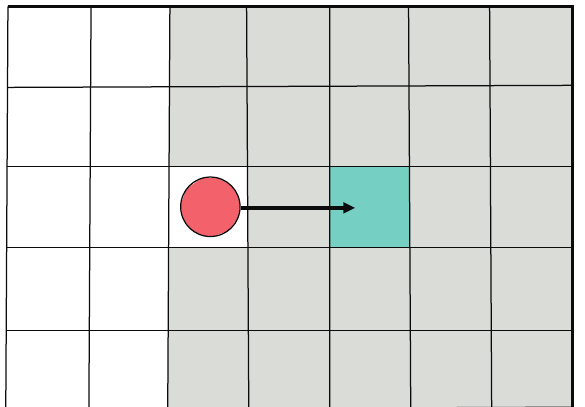
Figure 12: Density range observed for